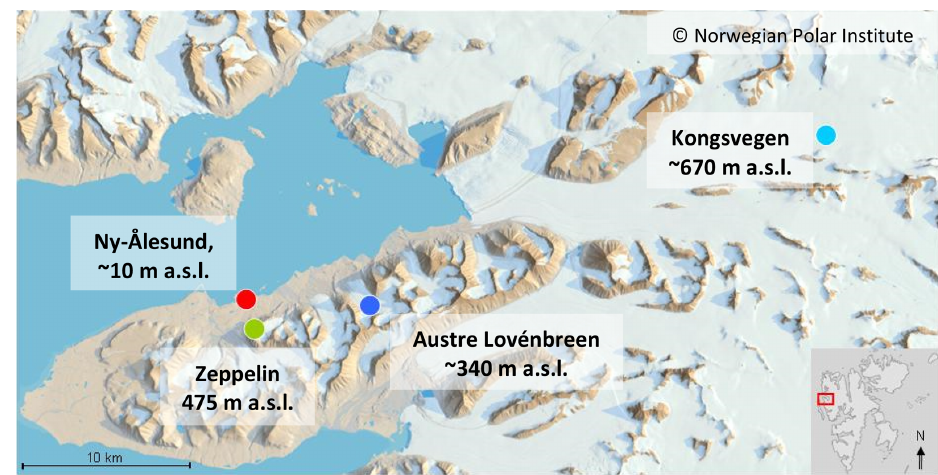
Figure 1. A 3-D map of the Kongsfjord area with Ny-Ålesund (red), Zeppelin Station (green), and the locations of the snow pits on the Kongsvegen (light blue) and Austre Lovénbreen glaciers (dark blue) indicated (adapted from ©Norwegian Polar